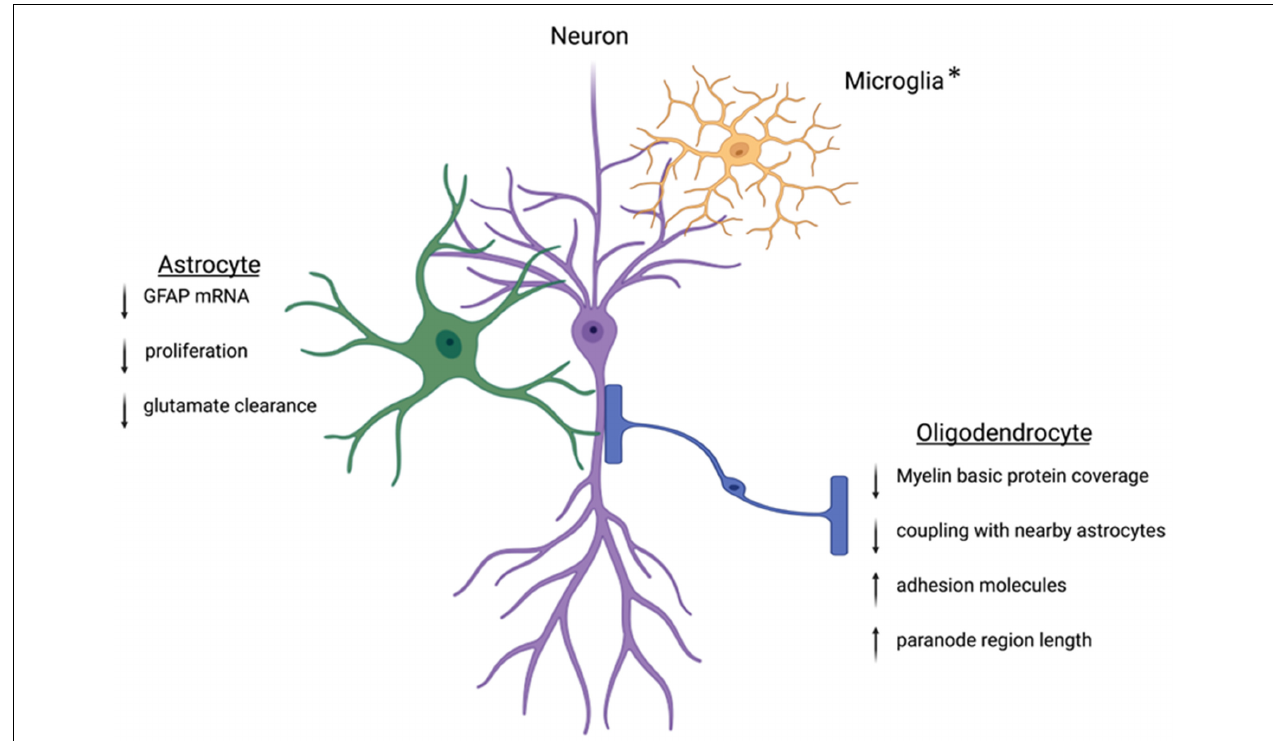
FIGURE 1 | Within the CNS, glia cells are positioned in close contact with neighboring neurons. This positioning allows the glial cells to tightly control the environment and facilitate neuronal communication. Following stress, this regulation can become dysregulated. Key proteins involved in astrocyte function are downregulated leading to decreased cradling at the synapse and altered glutamate homeostasis. Oligodendrocytes will experience downregulation of the key myelin basic protein and altered wrapping at the neuronal axon. Preclinical works suggest protein dysregulation following stress is different between males and females, but more work is needed to understand these mechanisms. ∗ Microglia are intimately associated with the synapse and other nearby glia cells. The interactions between microglia and neurons can be disrupted following stress. While microglia are not discussed in this review, other reviews have extensively outlined the ways microglia contribute to sex differences in the stress response (Bilbo et al., 2012; Bekhbat and Neigh, 2018; Rainville and Hodes, 2019). Created with